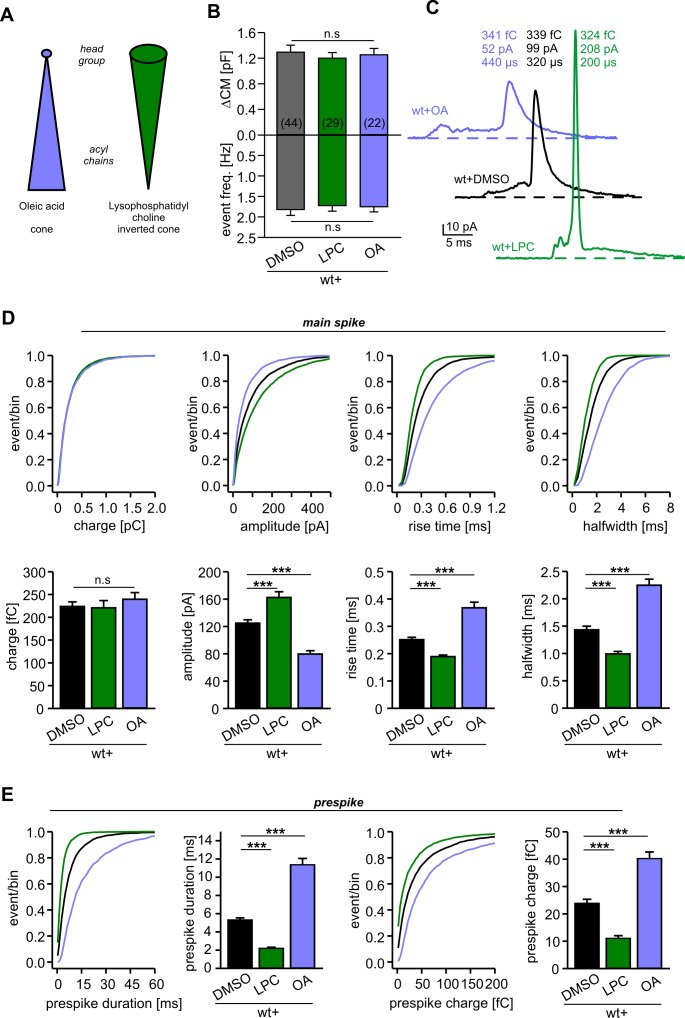
Extracellular application of cone and inverted cone shaped lipid molecules differentially controls fusion pore kinetics.(A) Schematic representation of oleic acid (OA, cone) and lysophosphatidyl choline (LPC, inverted cone) inducing negative and positive curvature of the membrane, respectively. (B) Extracellular application of LPC or OA does not affect the average ∆CM (top) or the amperometric event frequency (bottom). Data are averaged from the indicated number of cells. (C) Exemplary amperometric events with similar charge but altered kinetic release profile for the indicated conditions. (D) Cumulative frequency distributions (upper panels) and cell-weighted averages (lower panels) for the indicated parameter of the main spike. Note that LPC accelerates the spike waveform, whereas OA slows down the current transient. (E) Extracellular LPC and OA oppositely affect the prespike phase. LPC shortens the prespike duration and reduces the prespike charge, while OA prolongs the prespike duration and increases its charge. Values are given as mean of median determined from the indicated parameter’s frequency distribution for each cell. Data were collected from cells/events measured for wt+DMSO (44/4322), wt+LPC (29/3554), wt+OA (22/2616). Only cells with >20 events were considered. Data are represented as mean ± SEM. ***p<0.001, one-way analysis of variance followed by Tukey-Kramer post test.